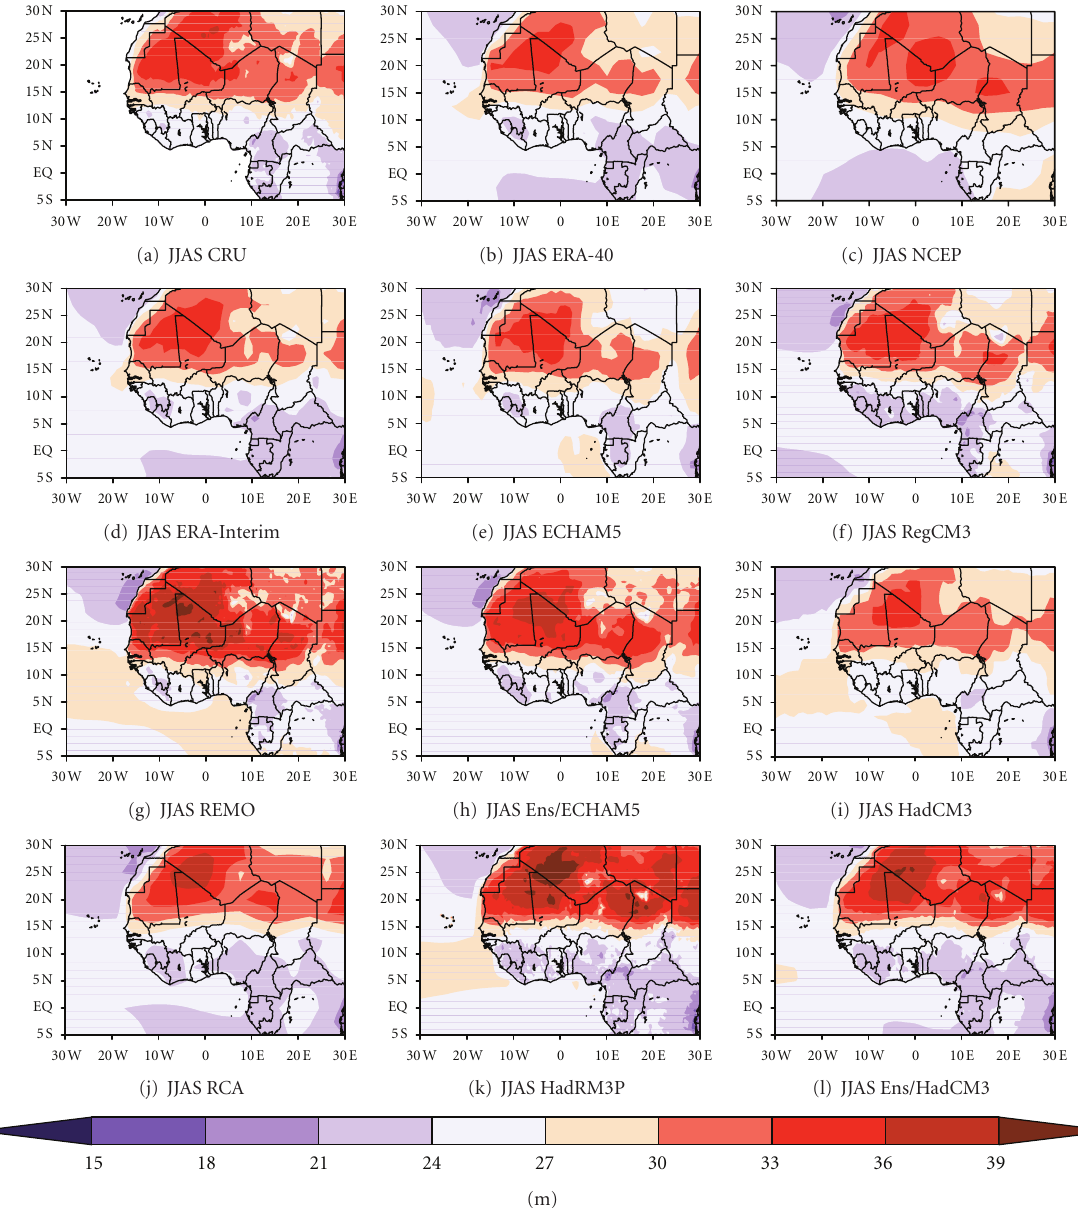
Figure 2: 1981–2000 averaged JJAS of temperature (in ◦ C) from: (a) CRU observation, (b) ERA-40 reanalysis, (c) NCEP reanalysis, (d) ERA- Interim reanalysis, (e) ECHAM5, (f) RegCM3, (g) REMO, (h) Ens/ECHAM5 (ensemble mean of RCMs driven by ECHAM5), (i) HadCM3, (j) RCA, (k) HadRM3P, and (l) Ens/HadCM3 (ensemble mean of RCMs driven by HadCM3).